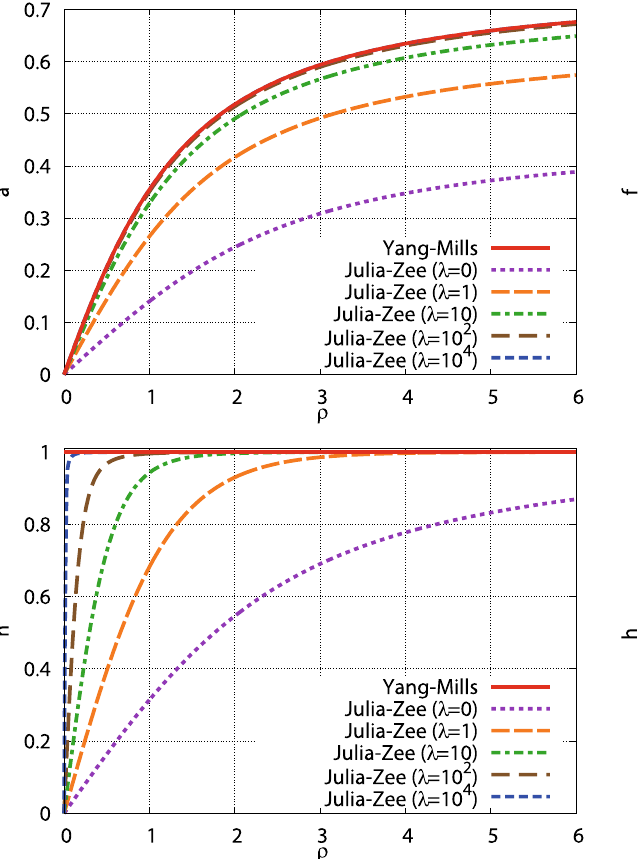
radially fixing constraint h (ρ) ≡ 1 holds even at the origin ρ = 0 in the Yang–Mills dyon, while the naive λ → ∞ limit of the Julia–Zee dyon approaches the limit value, h JZ (ρ) → 1 only for ρ > 0 except the origin ρ =